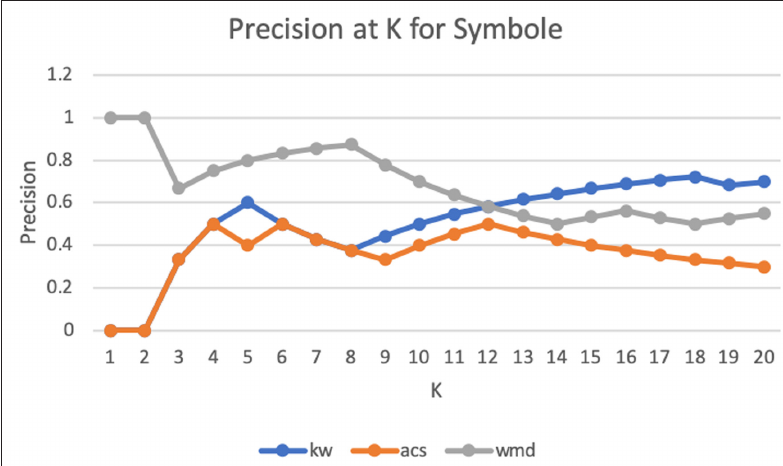
Figure 7: P@K for “symbole”.